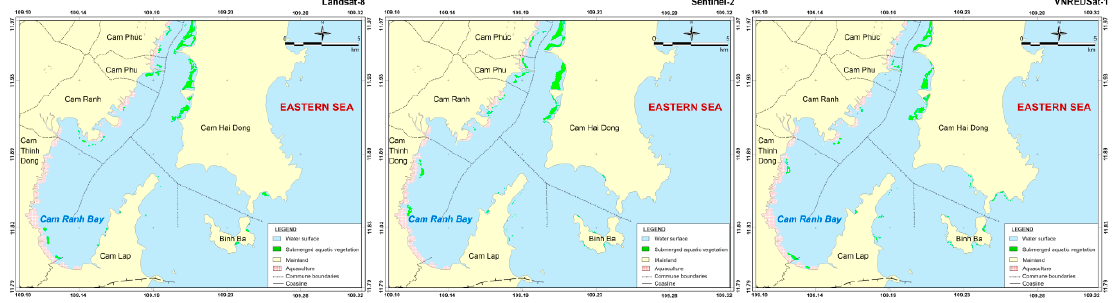
Cam Ranh Bay: in this sub-section, SAV distribution was restricted to shallow waters and the area around Binh Ba Island (Figure 10), with an estimated total acreage of 144.4 ha (V1 image, Table